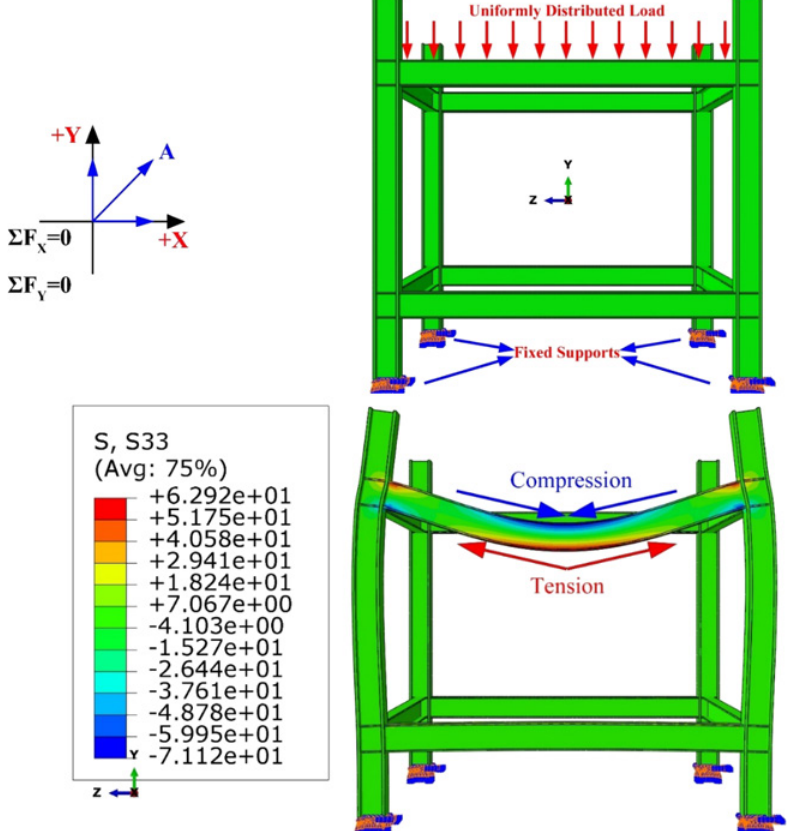
Figure 4 Animations showing load transfers and load components.